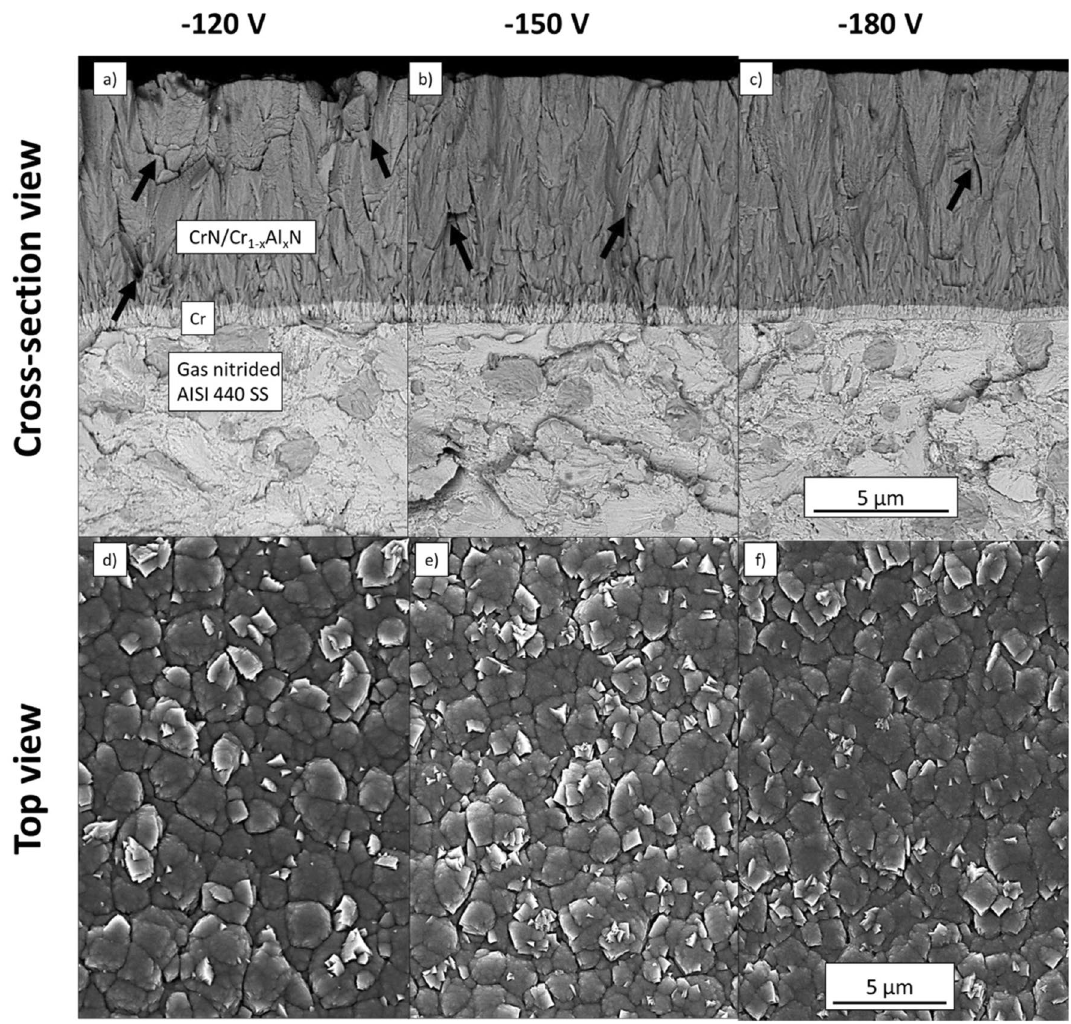
Figure 1. FEG–SEM micrographs of fractured cross-sections ( a – c ) and top surfaces ( d – f ) observed from CrN/ Cr 1-x Al x N multilayers manufactured at constant carousel speed (1 rpm) and the different biases. The black arrows indicate the presence of intergranular